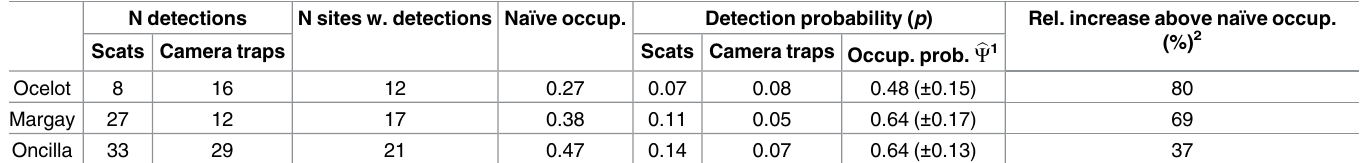
Table 1. Number of records (detections) by each method (scat sampling and cameratrap), number of sampling sites with detections, na ï veoccu- pancy, estimated occupancy probability ( b C ) from single-season single-species models, and relative increaseabove na ï veoccupancy when using estimatesof the three Neotropical spotted cats in a large Atlantic Forest remnant. N detections N sites w. detections Na ï ve occup.